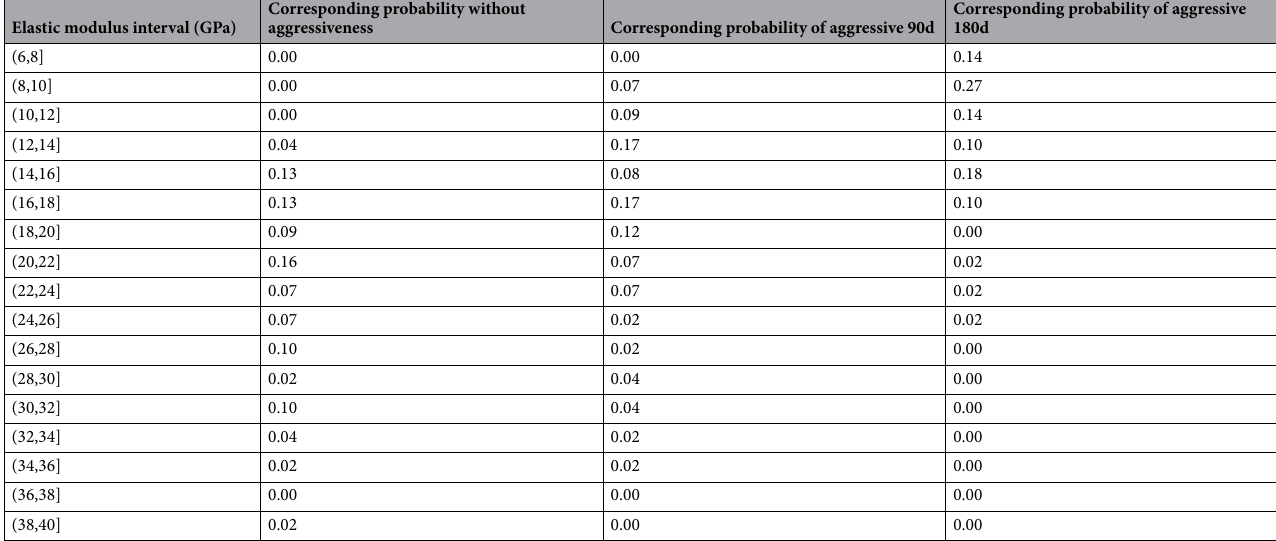
Table 3. Probability distribution of the elastic modulus after high-concentration aggressiveness.